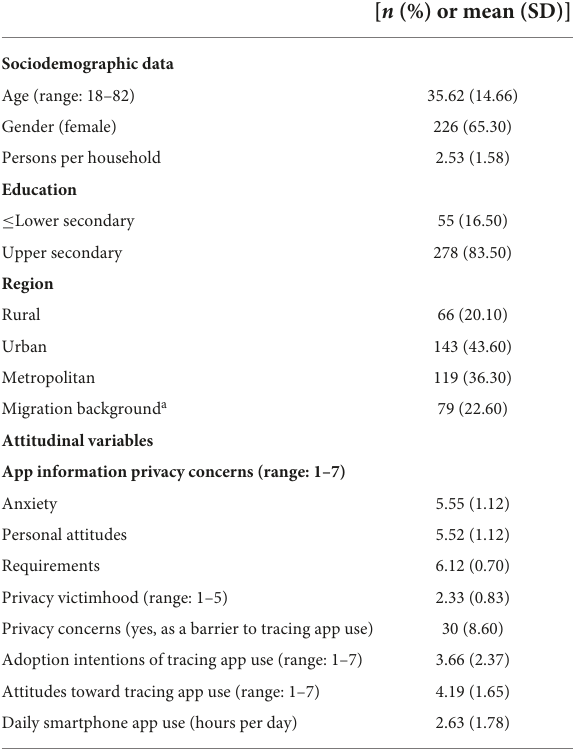
Total ( N = 349) [ n (%) or mean